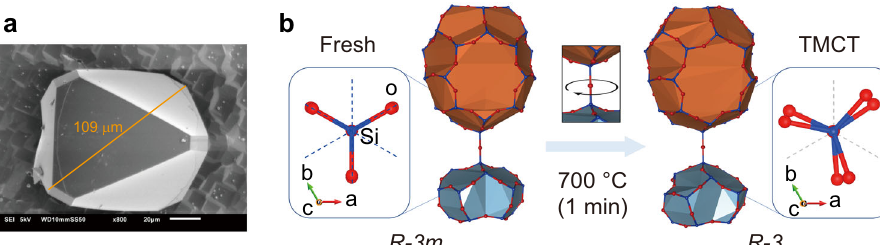
Fig. 3 Structural relaxation of DDR-type zeolite during TMCT treatment. a SEM image of DDR-type zeolite crystal. b Rotation of silica tetrahedra during TMCT procedure, transferring the space group from R -3 m to R -3. The silicon and oxygen atoms are highlighted in blue and red color to demonstrate the structure relaxation. Fresh, as-synthesized zeolite; TMCT, overheating at 700 °C for 1